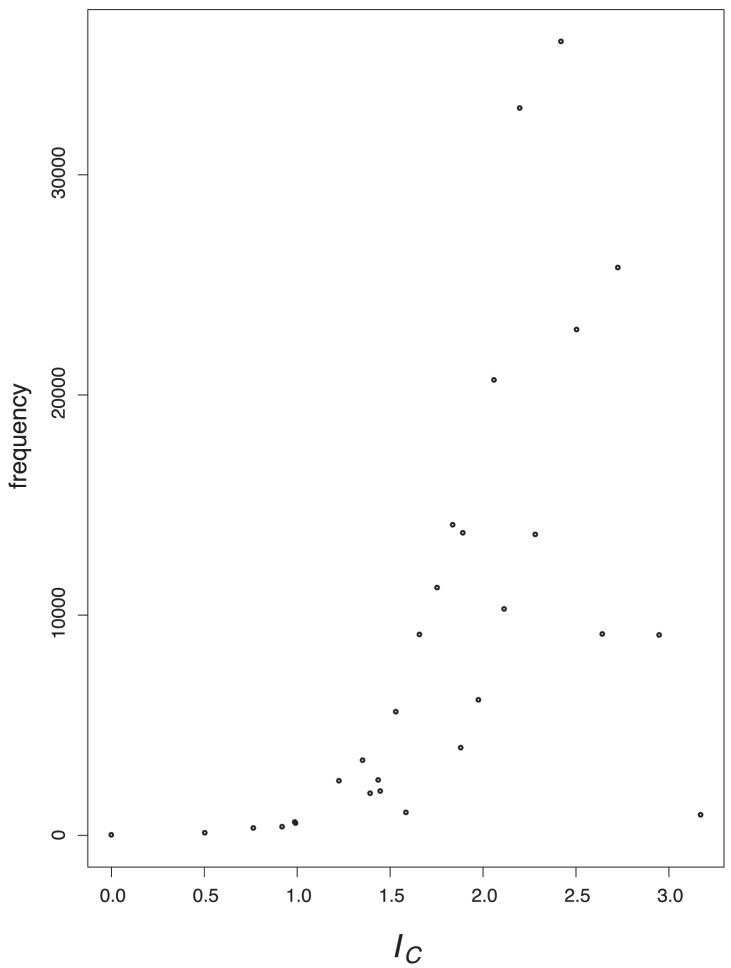
Value distribution for IC.